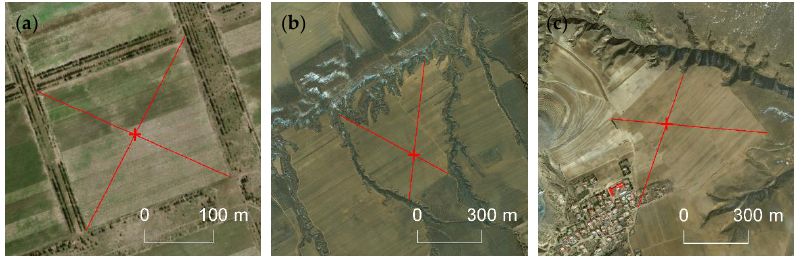
Figure 3. Scheme for setting GCPs on ESRI ’s online World Imagery layer (Environmental Systems Research Institute, Inc., United States). Subgraphs ( a – c ) show the locations of GCPs determined by intersections of forest belts, ditches in farmlands, and edges of buildings and valleys, respectively.